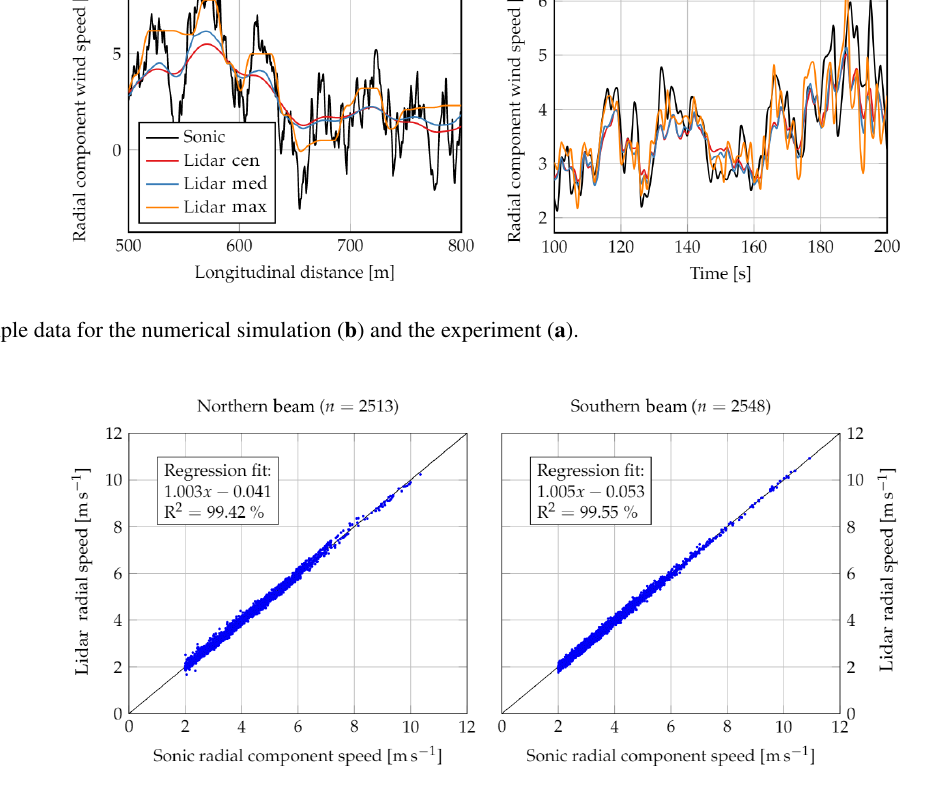
Fig. 2. The lidar beams are aligned horizontally to measure horizontal components only. The focus distance is 90 m